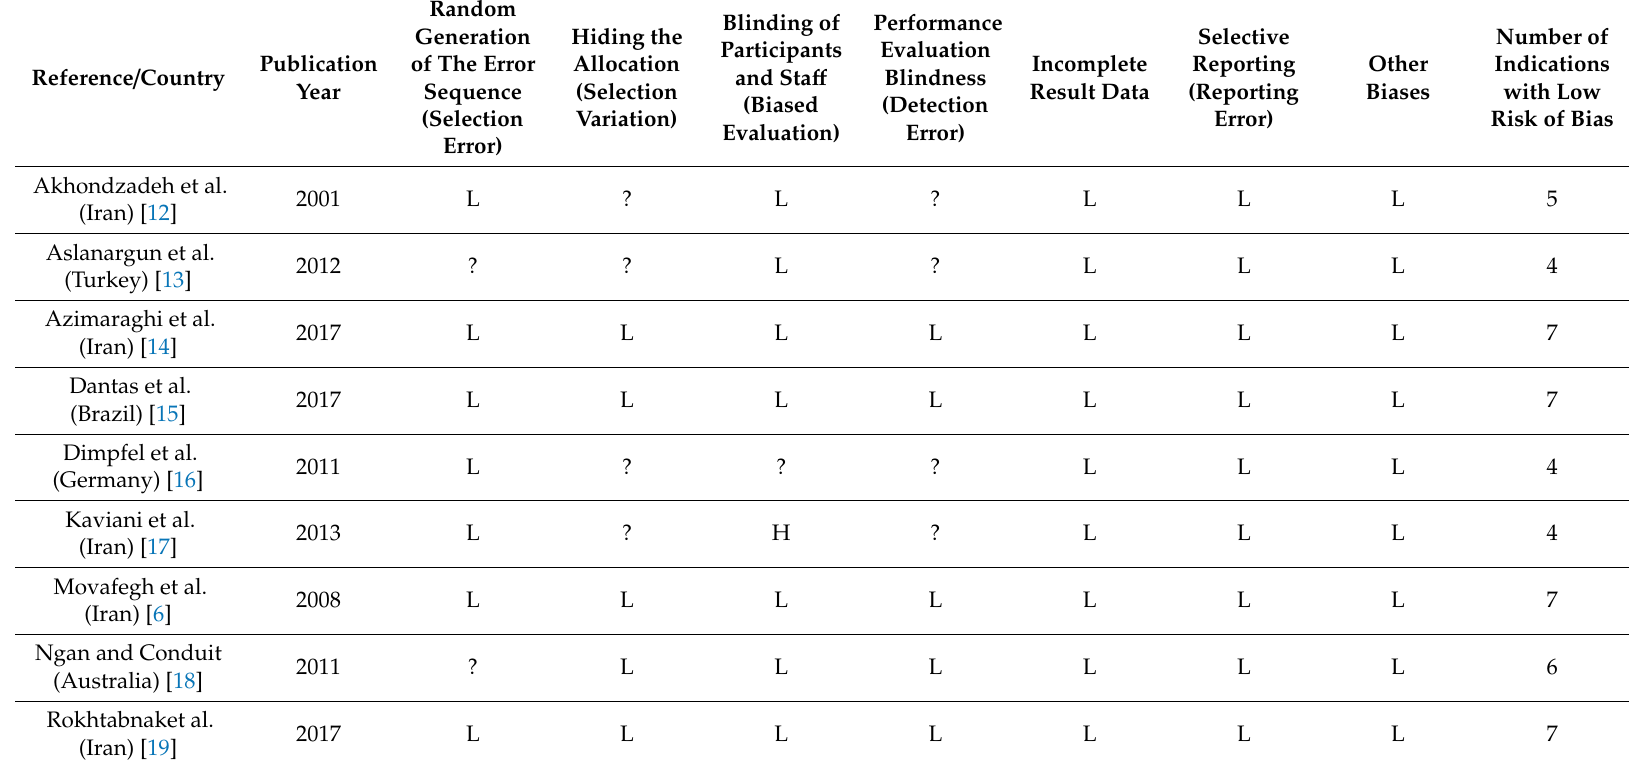
Table 4. Risk of bias